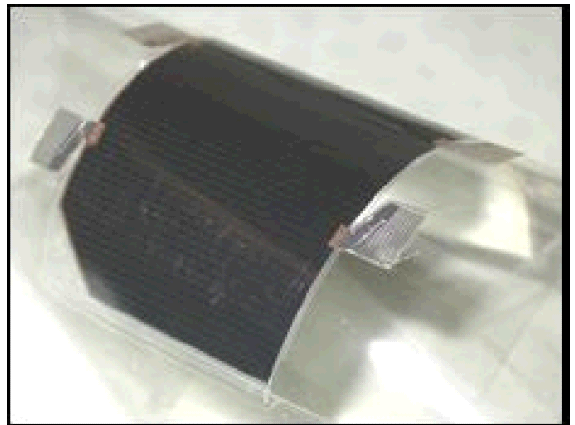
Figure 8. Photograph of a flexible thin-film InGaP/GaAs dual-junction 4 × 7 cm 2 film- laminated cell (reprinted from [33]; © 2006, with permission from